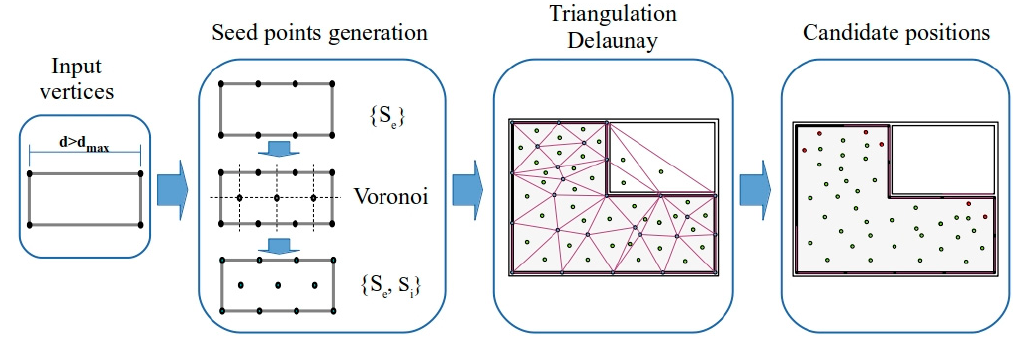
Figure 5. Workflow of the triangulation process.